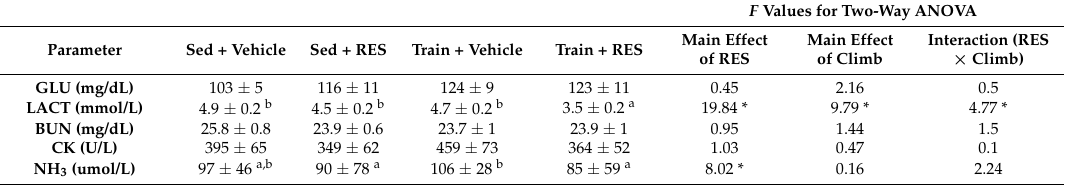
F Values for Two-Way ANOVA